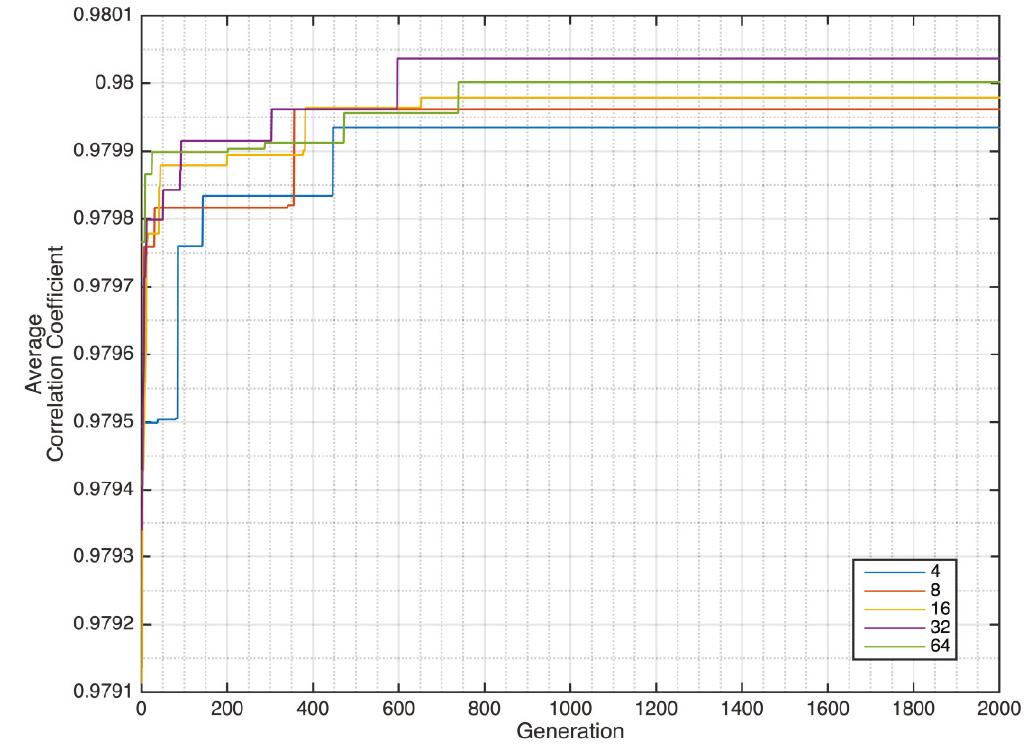
Figure 6. Genetic deep autoencoder (GDCAE) generation convergence.